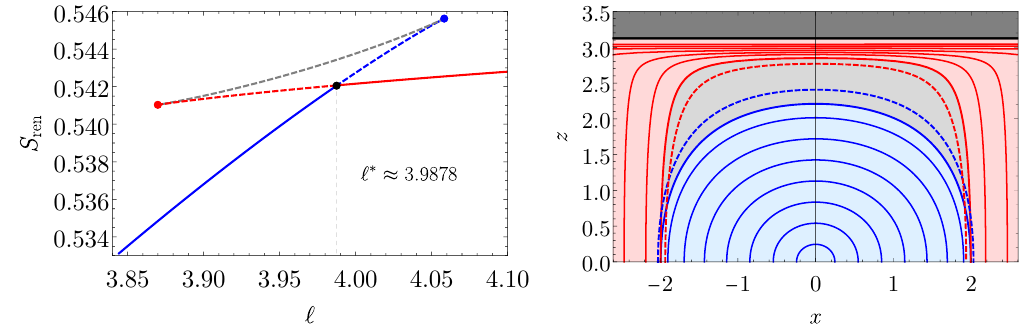
Figure 6 . Left: EE in intermediate region. Right: minimal surfaces in domain wall